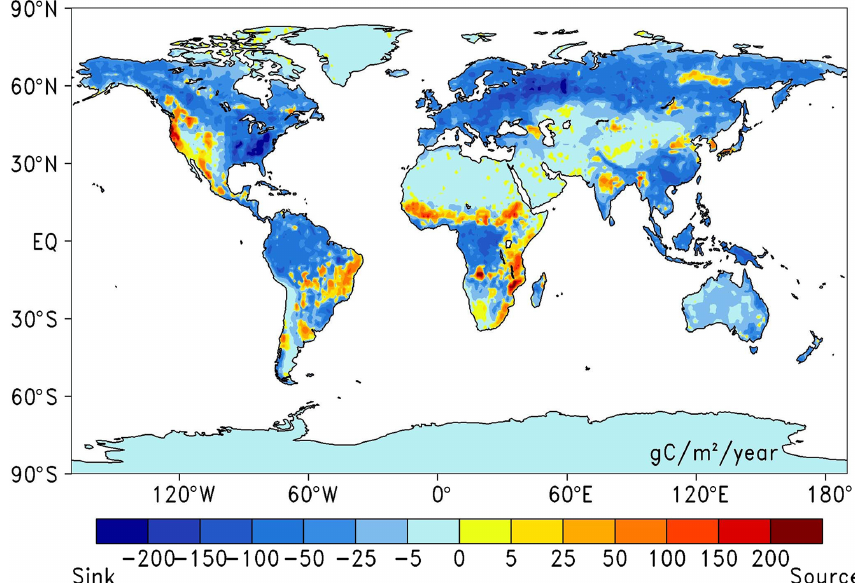
Figure 5. Global distribution of mean annual NEE during